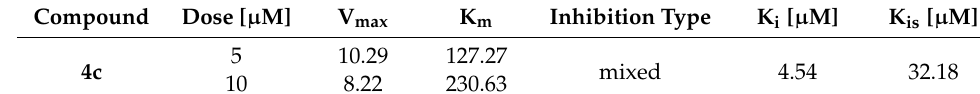
Table 2. Kinetic analysis of mechanism of elastase inhibition by compound 4c . Table 2 . Kinetic analysis of mechanism of elastase inhibition by compound 4c .